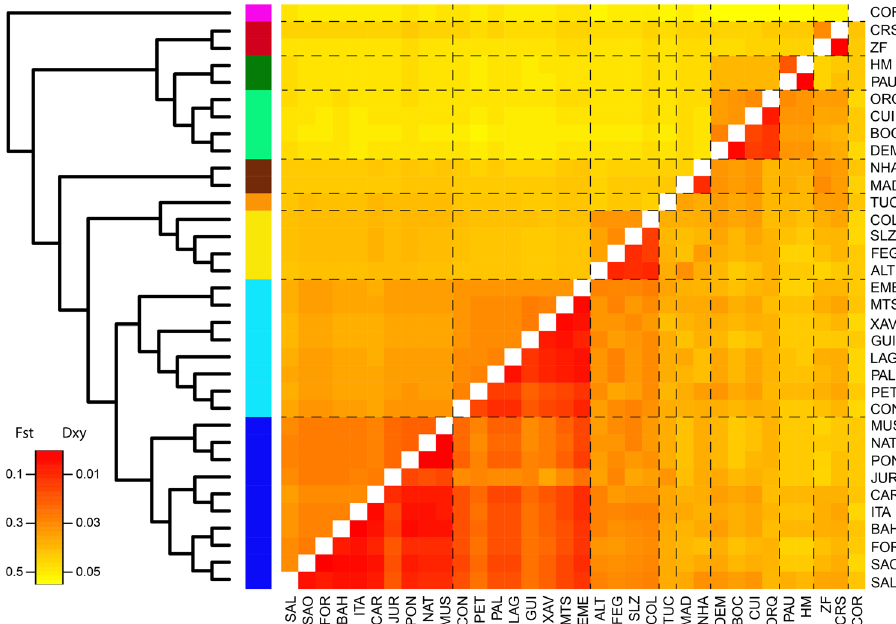
Figure 3. Genetic differentiation among populations of Protium heptaphyllum s.l . Pair-wise genetic distances among P. heptaphyllum s.l . populations based on two metrics: F ST (lower matrix), a relative measure of genetic differentiation within and between pair-wise populations, and D xy (upper matrix), an absolute measure of genetic divergence between pair-wise populations. Colored bars correspond to populations assignment based on the STRU CTU RE analysis. Heatmap generated using heatmap function in RStudio version 1.1.447 (https:// rstud io. com/ produ cts/ rstud